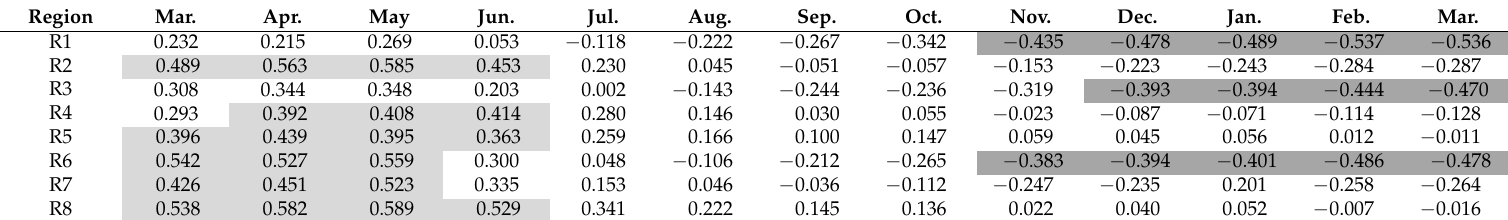
Table 5. Correlation coefficient values between the NEM rainfall and the MEI at various concurrent and leading months. Region Mar. Apr. May Jun. Jul.